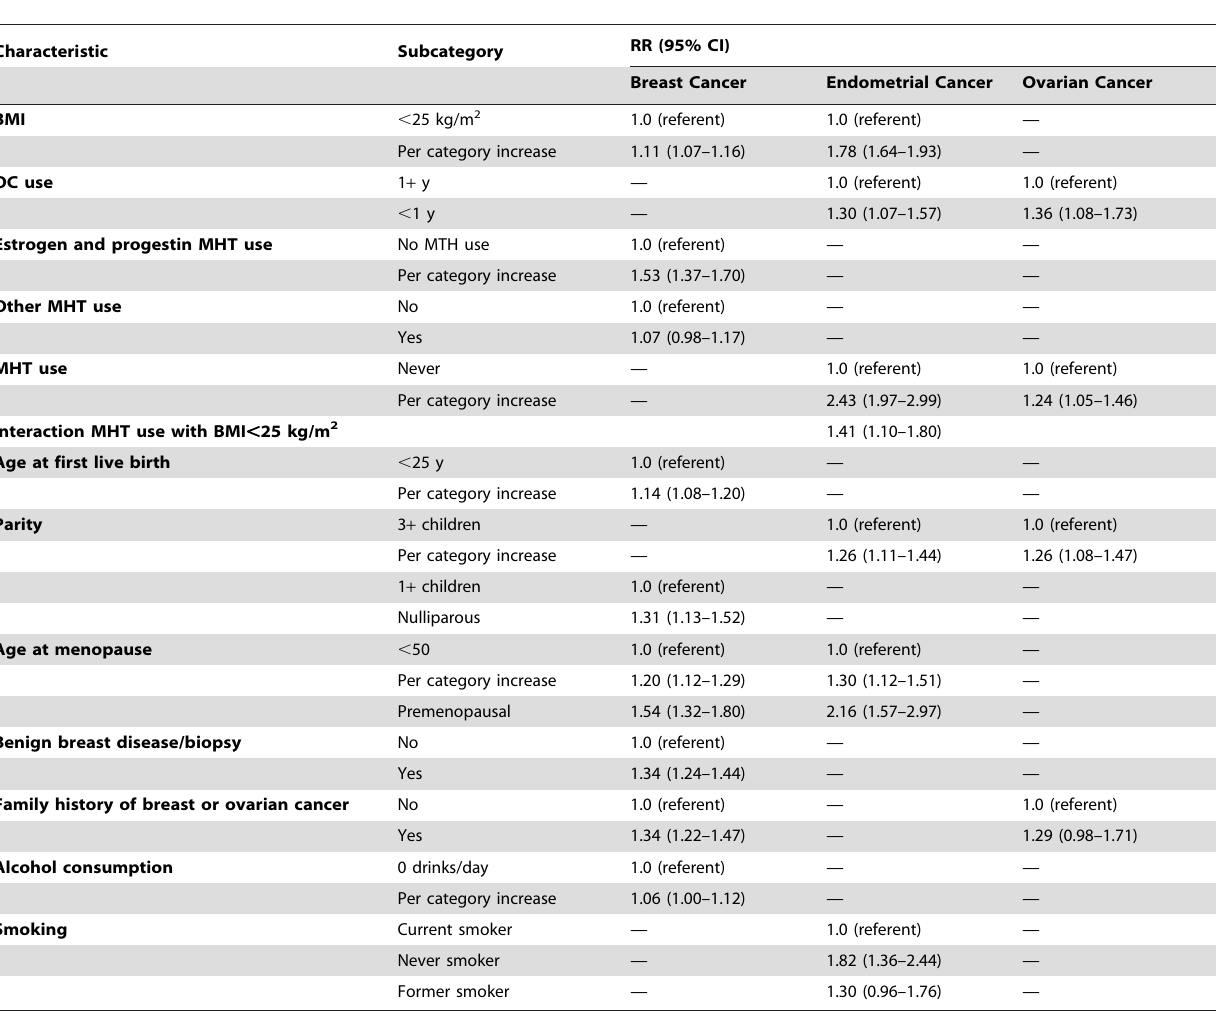
Table 8. Multivariate relative risk estimates for breast, endometrial, and ovarian cancer among non-Hispanic, white women in the NHS validation